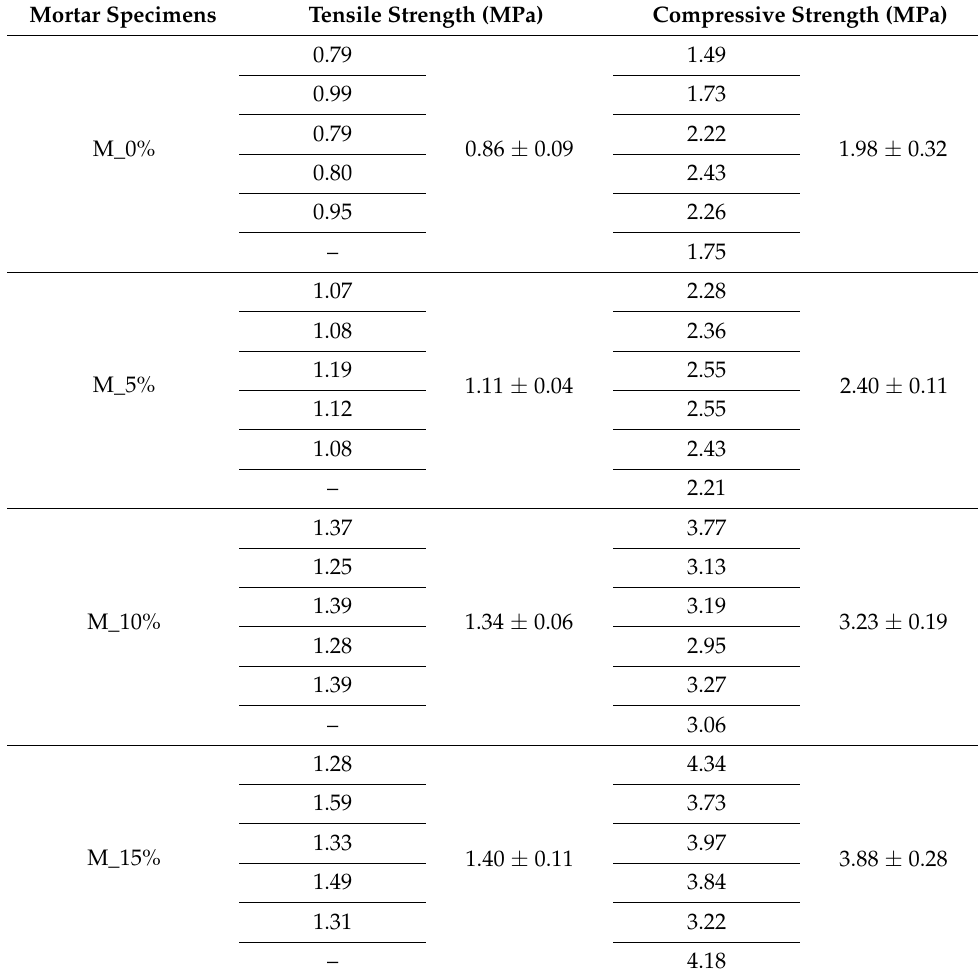
Table 5. Hardened mortar prisms with kneading water replaced by different percentages of lime solution. Mortar Specimens Tensile Strength